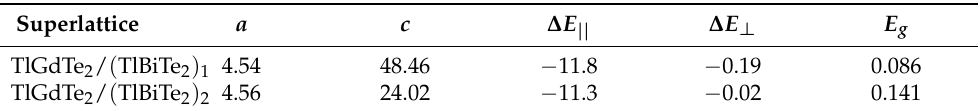
Table 2. The same as Table 1, but for TlGdTe 2 /(TlBiTe 2 ) n . Note that for n = 1, the c parameter is approximately twice as large as the one for n = 2 because the hexagonal unit cell of the former contains 24 atoms as compared to 12 of the latter.